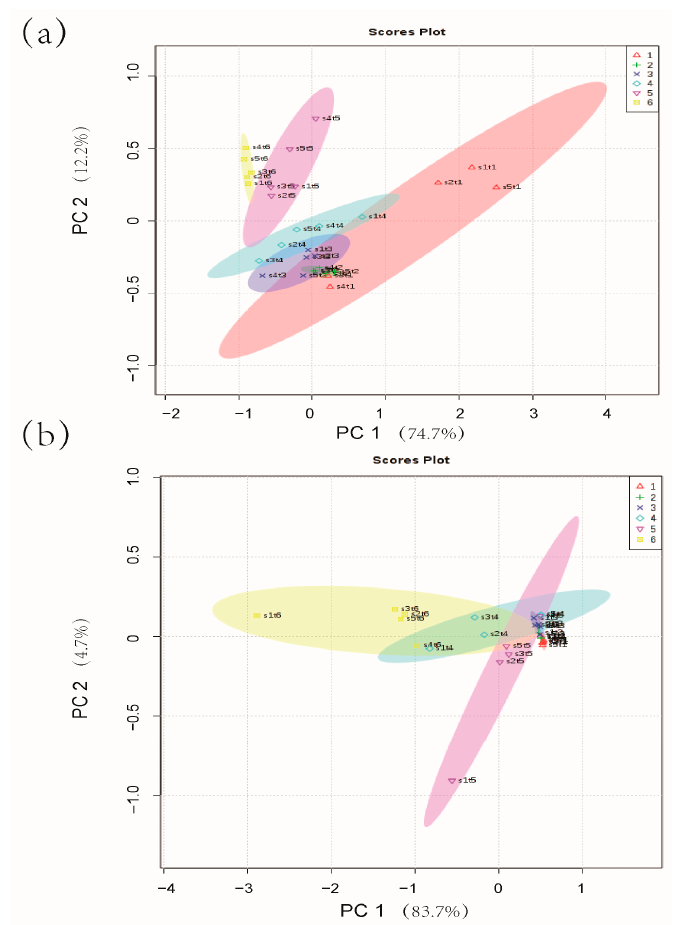
Figure 2. PCA analysis of compounds. ( a ) Storage time at 4 °C: class 1 represents 0 day, class 2 represents 4 day, class 3 represents 8 day, class 4 represents 12 day, class 5 represents 18 day, and class 6 represents 20 day; ( b ) Storage time at 25 °C: class 1 represents 0 h, class 2 represents 24 h, class 3 represents 36 h, class 4 represents 48 h, class 5 represents 60 h, and class 6 represents 72 h.